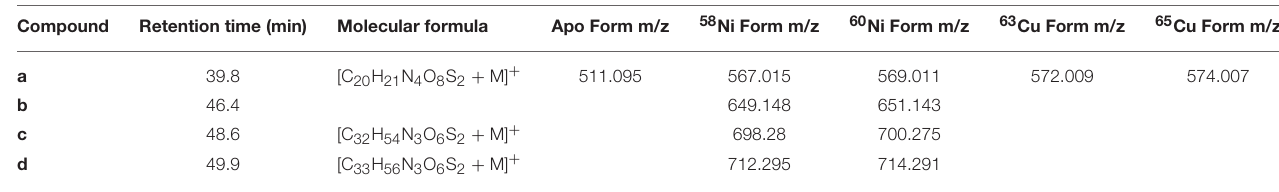
TABLE 2 | Ni and Cu compounds detected across the GEOTRACES EPZT transect.